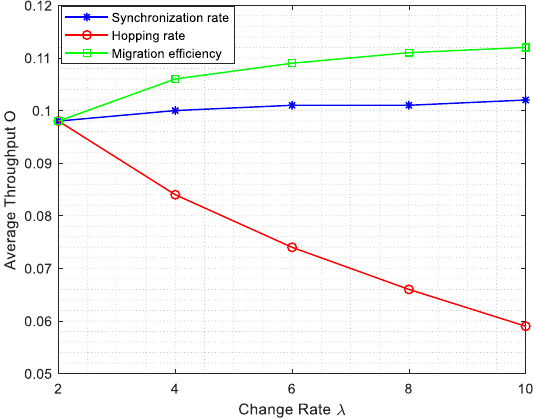
Figure 13. Effect of change rate on Average